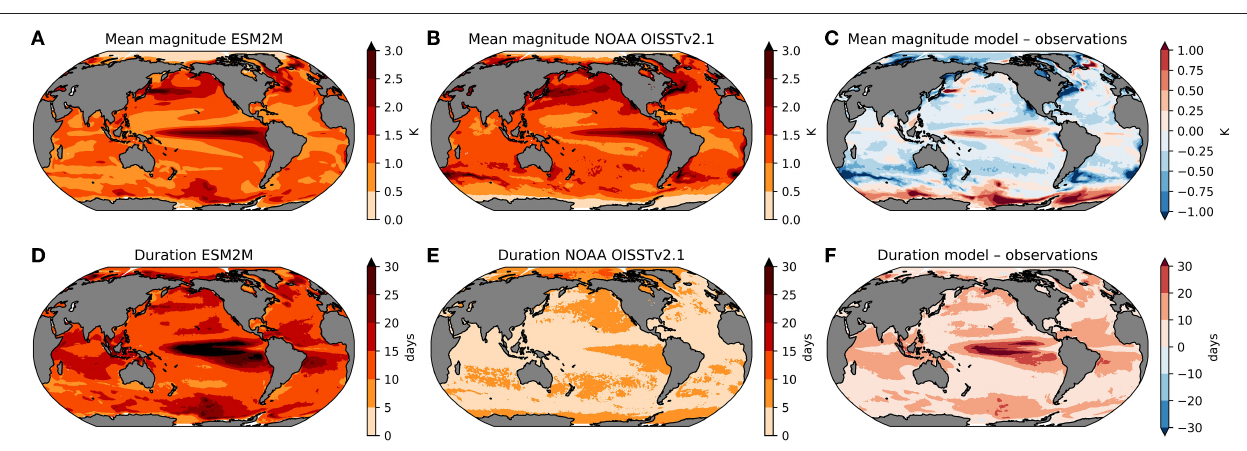
FIGURE 2 | Comparison between simulated and observed marine heatwave mean magnitude (top row) and duration (bottom row). The marine heatwave metrics are calculated from (A,D) the 500-yr preindustrial control simulation and (B,E) the NOAA OISST v2.1 dataset spanning the period from September 1st 1981 to December 24th 2020. The NOAA OISST v2.1 dataset is a blend of satellite and in situ ship, buoy, and Argo float sea surface temperature observations interpolated onto a global 1/4 ◦ resolution grid (Huang et al., 2020). (C,F) Differences between simulated and observation-based estimate. The NOAA OISST data was regridded onto the MOM4p1 grid after computing MHW metrics for comparison. Results for the GFDL ESM2M are similar when using a 1981–2021 reference period (not